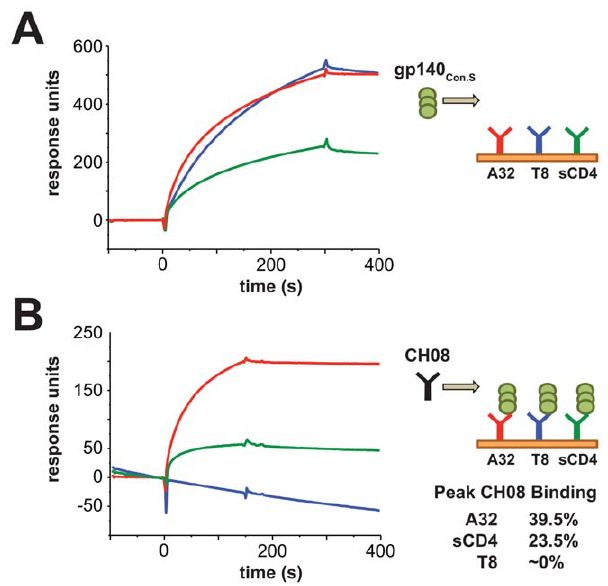
Figure 5. MAb CH08 is a CD4i HIV Env-specific antibody. CH08 mAb binding to gp140 Con.S after capture by mAb T8 (HIV gp120-specific mAb), soluble CD4 (sCD4), or mAb A32 (CD4 binding site mAb) was measured by SPR. A. gp140 Con.S bound to anchored T8, sCD4 and A32, data are shown in response units (RU). B. CH08 was flowed over the captured Env showing that it bound to Env captured by A32 and sCD4, but not Env captured by mAb T8. Peak CH08 binding as a fraction of bound Env is shown.